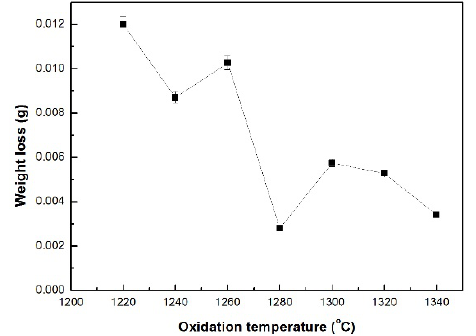
Figure 9. Weight loss of samples oxidized at di ff erent temperatures for 3 h.